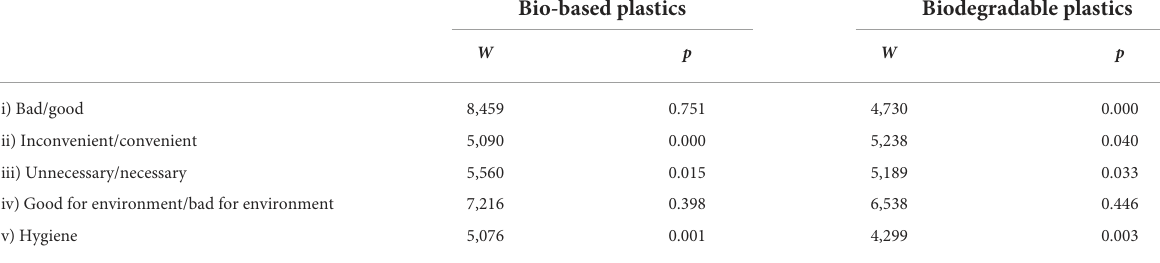
TABLE 3 Difference in evaluation of bioplastics before and after information